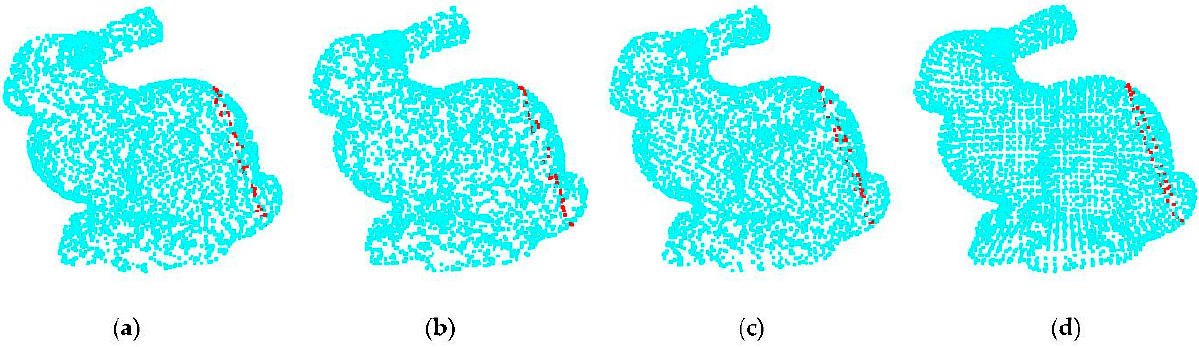
Figure 4. Point cloud down-sampling effect: ( a ) curvature down-sampling; ( b ) random down-sample; ( c ) uniform down-sample; and ( d ) voxel down-sample.